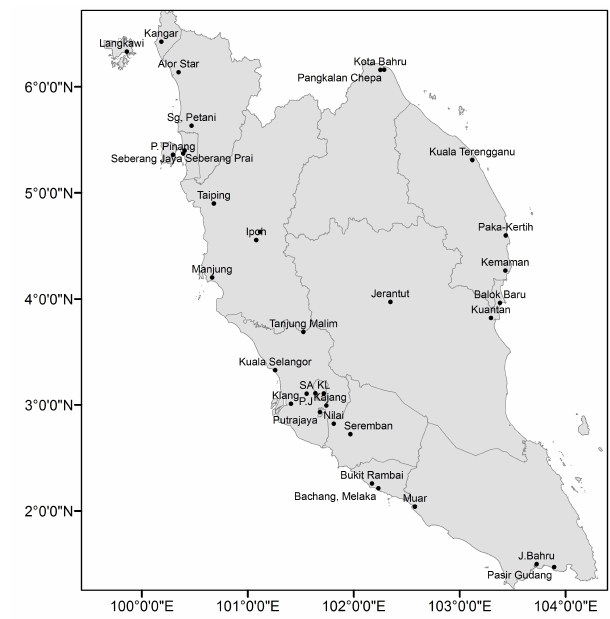
Fig. 1. Spatial distributions of 34 monitoring sites to be use in this study. (SA: Shah Alam; KL: Kuala Lumpur; J. Bahru: Johor Bahru; PJ: Petaling